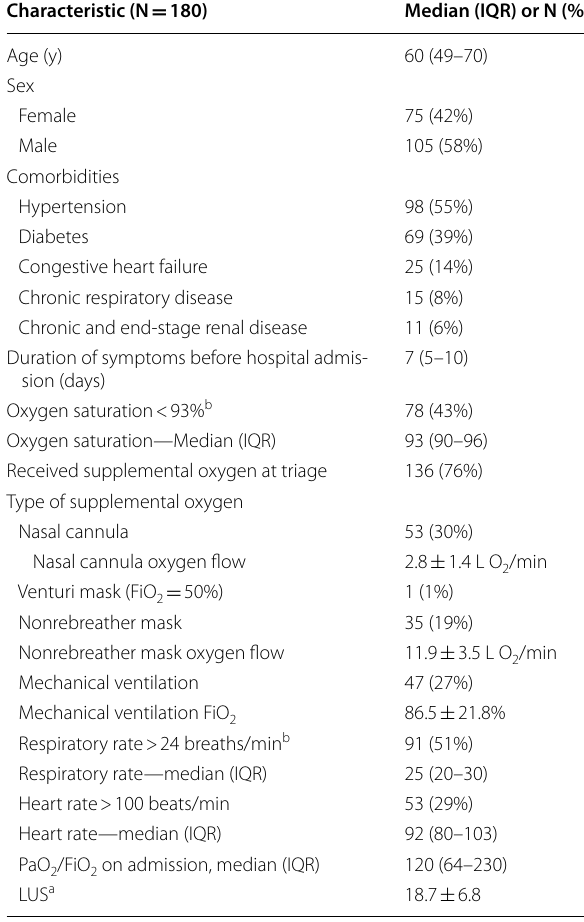
Table 1 Baseline characteristics of patients, vital signs, and laboratory results at